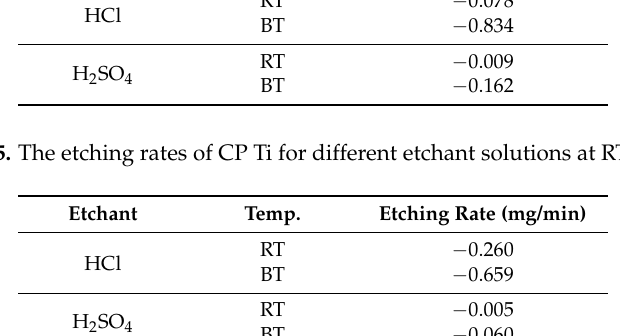
Table 4. The etching rates of Ti-6Al-4V ELI for different etchant solutions at RT or BT. Etchant Temp.